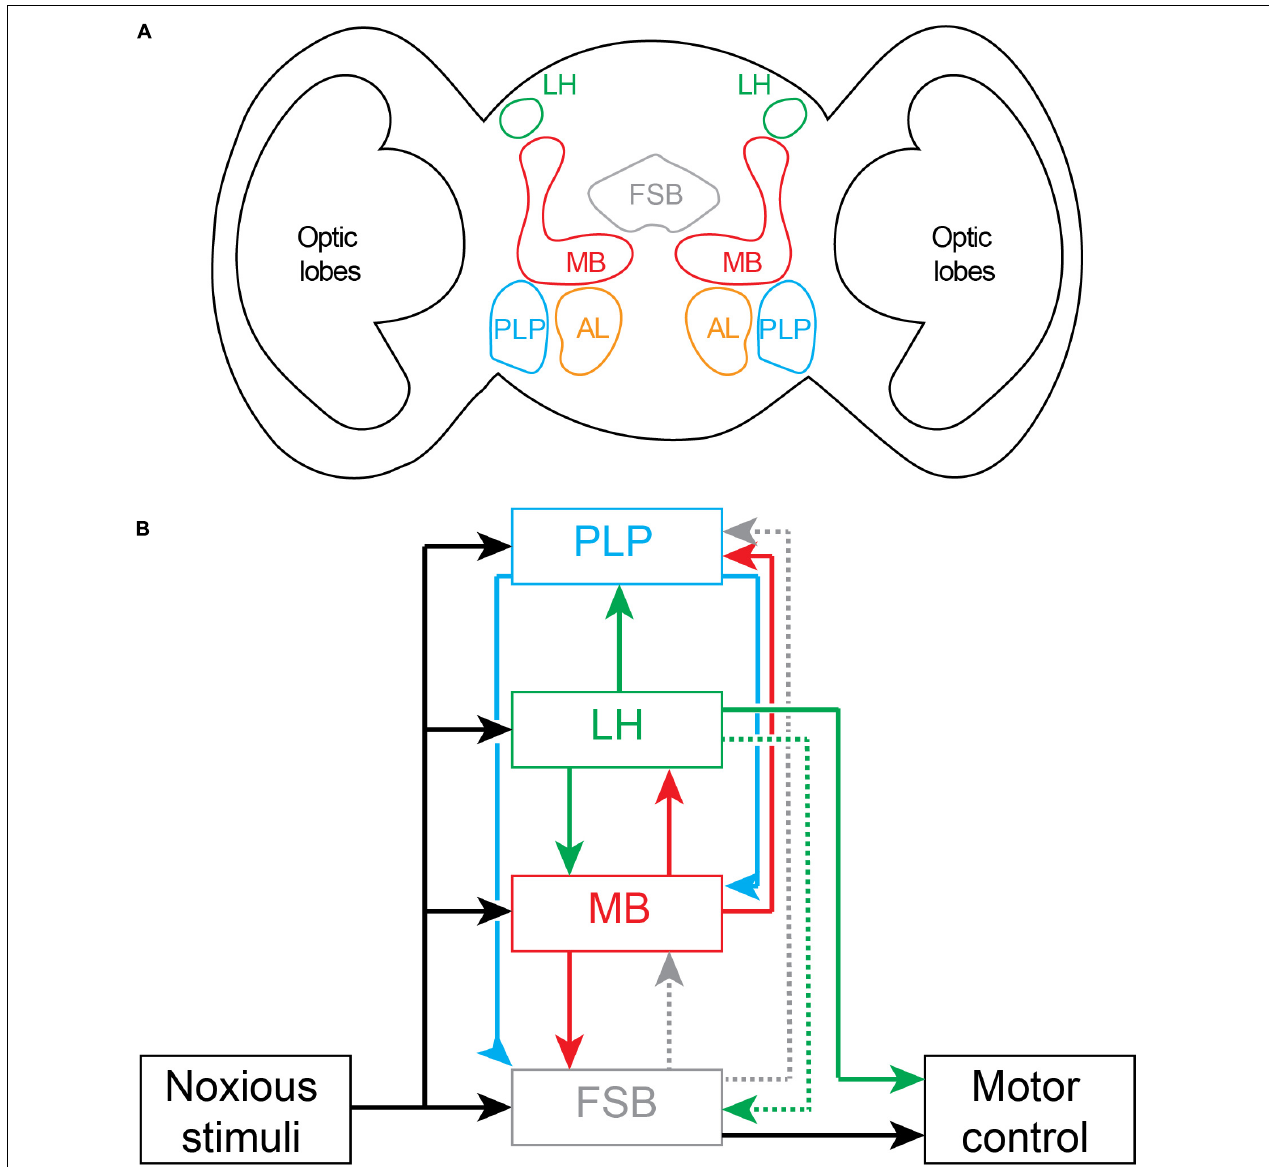
FIGURE 5 | Nociceptive processing in the adult Drosophila brain. (A) Schematic drawing of coronal section of brain showing location of major noxious processing regions. Fan Shaped Body (FSB); Lateral Horn (LH); Mushroom Body (MB), Posterior Lateral Protocerebrum (PLP); Antennal Lobe (AL). (B) Circuit diagram of brain regions processing noxious inputs. Dashed lines represent weak connectivity. The outputs driving motor behaviors arise principally from the fan shaped body and the lateral